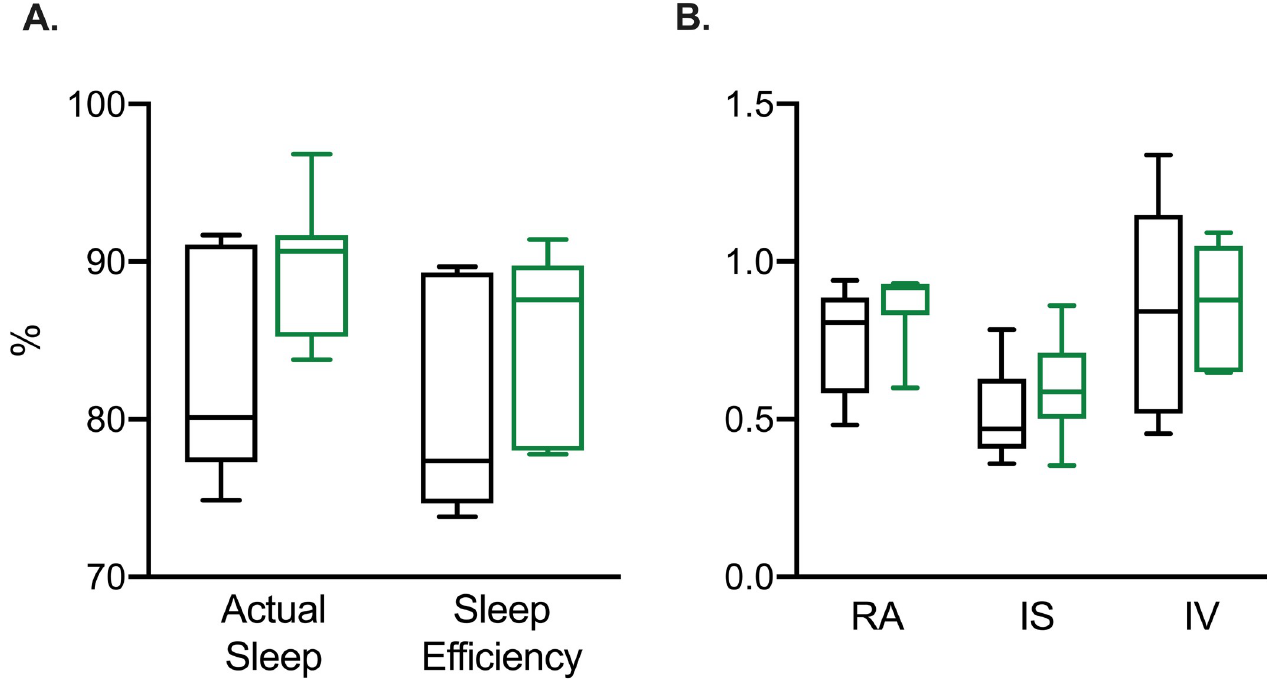
Fig 3. Wrist actigraphy measurements in pre-AD and controls. Box whisker plots of (A) Actual sleep (%) and Sleep efficiency (%), (B) Relative Amplitude (RA), Interdaily Stability (IS), Intra-daily Variability (IV) for controls (black, n = 5) and pre-AD individuals (green, n = 7). Actual sleep (%) was calculated as total sleep time in minutes divided by assumed sleep time (total elapsed time between ‘Fell Asleep’ and ‘Woke Up’ times). Sleep efficiency was calculated by the percentage of total sleep time divided by time in bed. Pre-AD, pre-symptomatic Alzheimer’s disease.